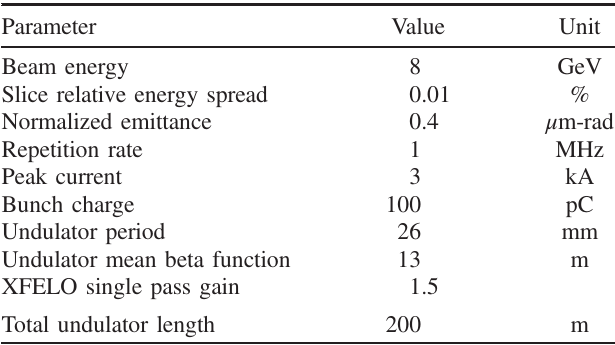
TABLE I. The main parameters of